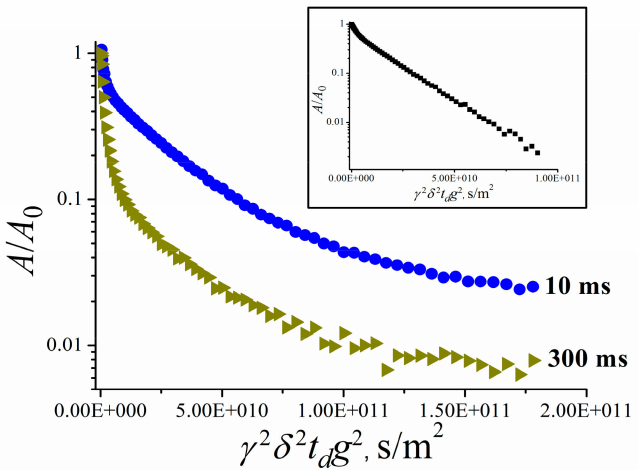
Figure 70. Diffusion decays at different diffusion times t d (indicated in the figure) of molecules 2 in RBCs suspension. Insert: diffusion decay of compound 2 in aqueous solution [173]. Reprinted with permission from [173]. Copyright 2021 Springer